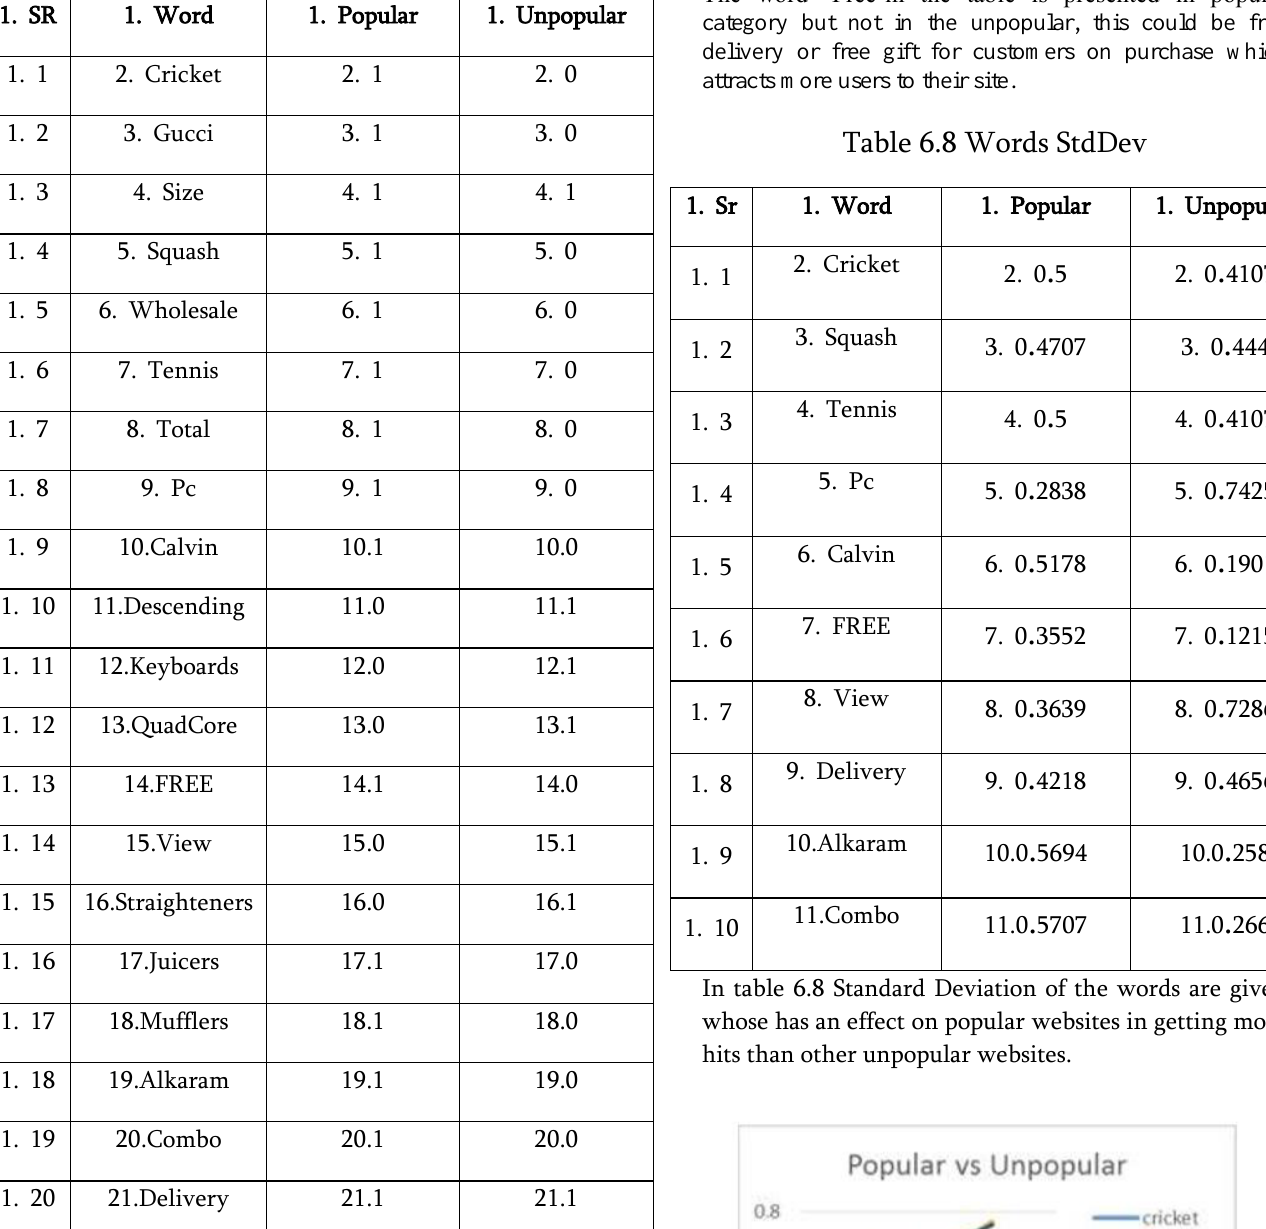
Table 6.7 Availability of Words Popular VS Unpopular by